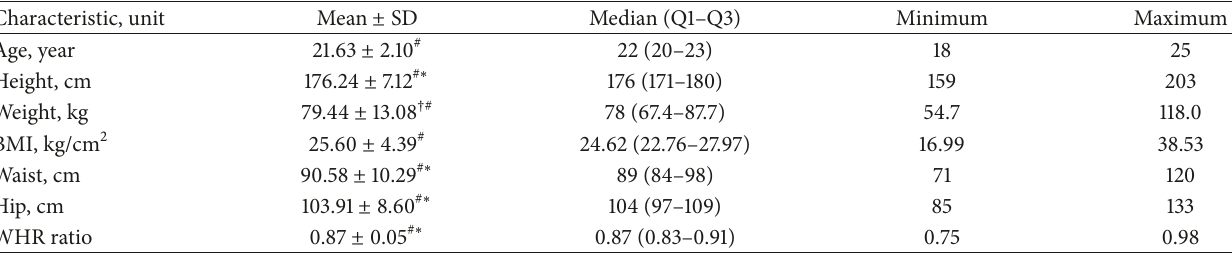
Table 1: Anthropometric characteristics of the participants (𝑛 = 101) ; the results are presented as mean ± standard deviation (SD), median, first and third quartiles (Q1–Q3), minimum, and maximum. Damascus, Syria, April 2016. Characteristic,